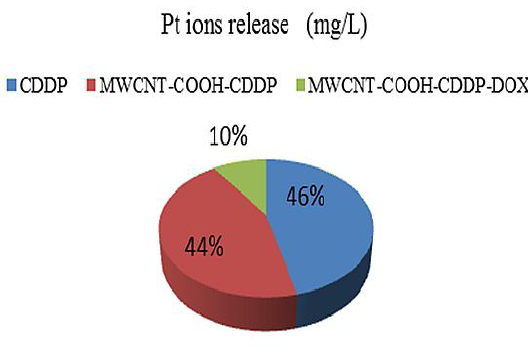
Figure 3. Pt ions release from CDDP, MWCNT-COOH-CDDP, MWCNT-COOH-CDDP-DOX.